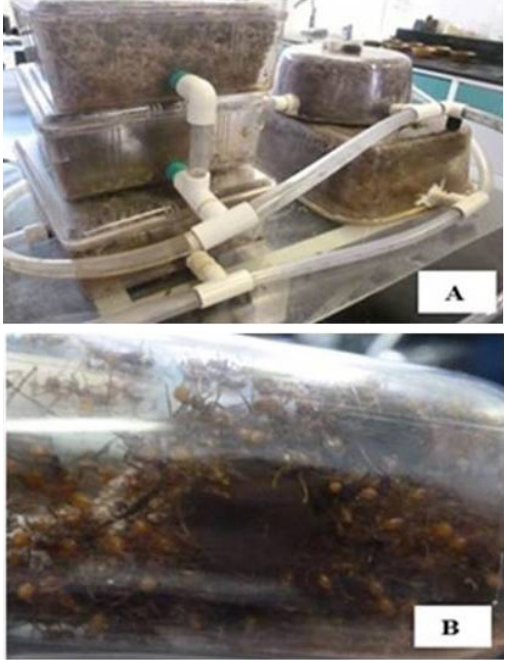
Fig 1. Artificial colony of Atta cephalotes (CIAT). A - Five months after the adoption of the surrogate queen. B - Live surrogate queen integrated into the orphan